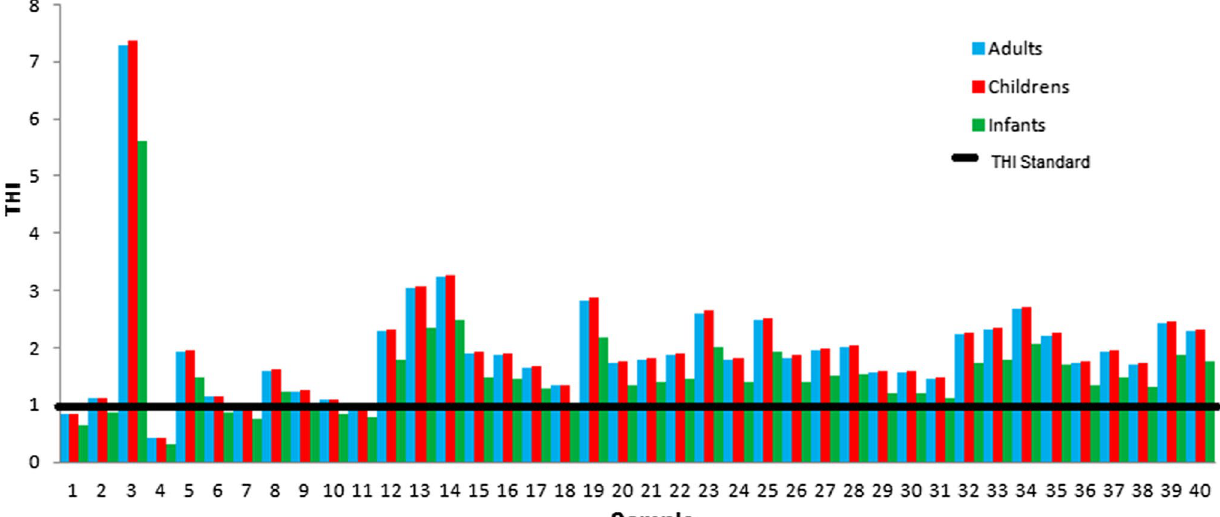
Fig. 10 Comparison of THI in the studied groups with THI